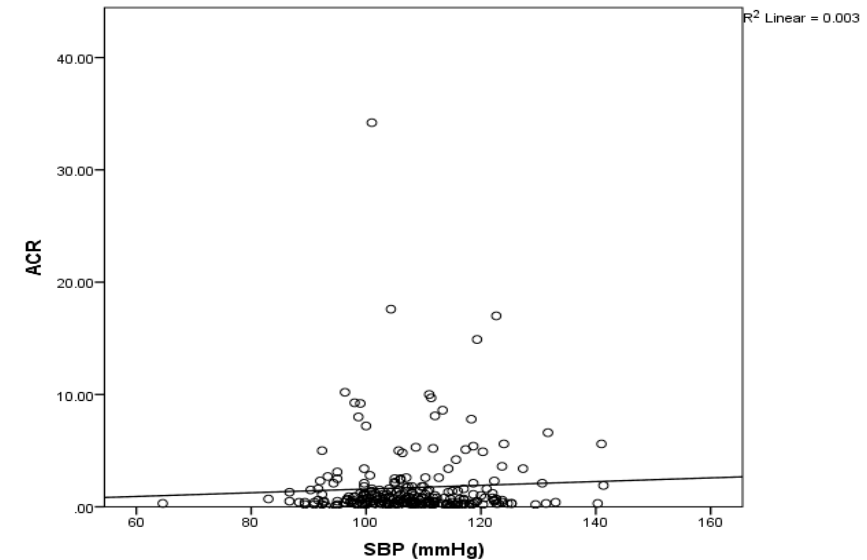
Figure 1. Correlation between systolic blood pressure (SBP) and albumin to creatinine ratio (ACR). There was a positive linear relationship with R 2 =0.003.